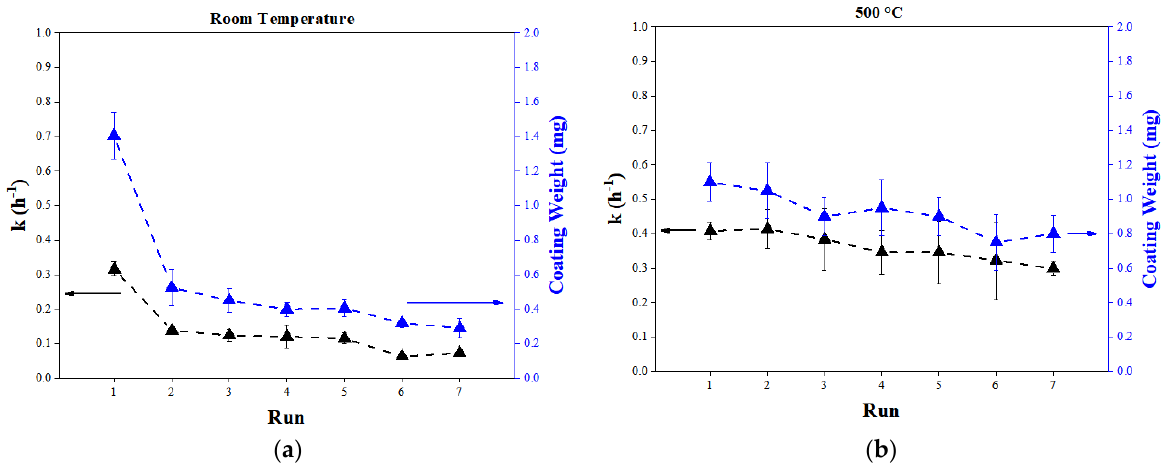
Figure 10. Photocatalysis kinetics and coating weight for nonannealed ( a ) and annealed ( b ) coatings over 7 runs.